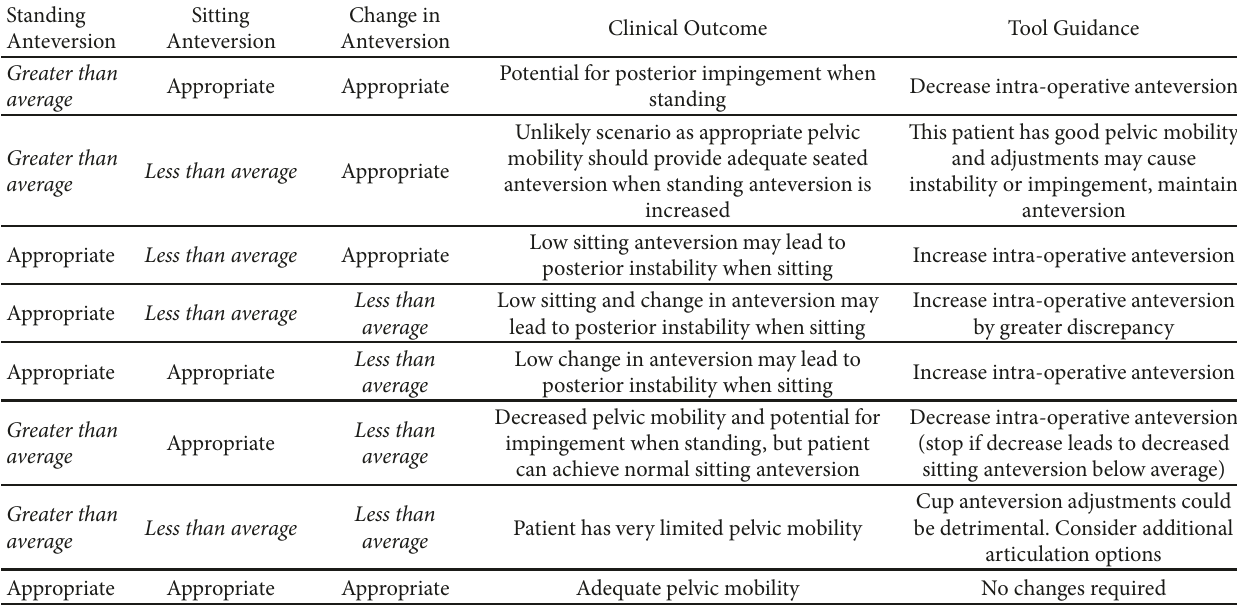
Table 2: Clinical scenarios comparing a patient’s calculated standing, sitting, and change in functional anteversion to the population-based averages and the respective guidance provided by the mobile application.